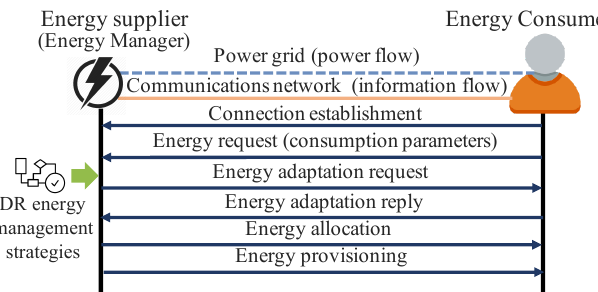
Figure 2. Energy adaptation process (handshake between the Energy Supplier (ES) and the Energy Consumer (EC)). Adapted from